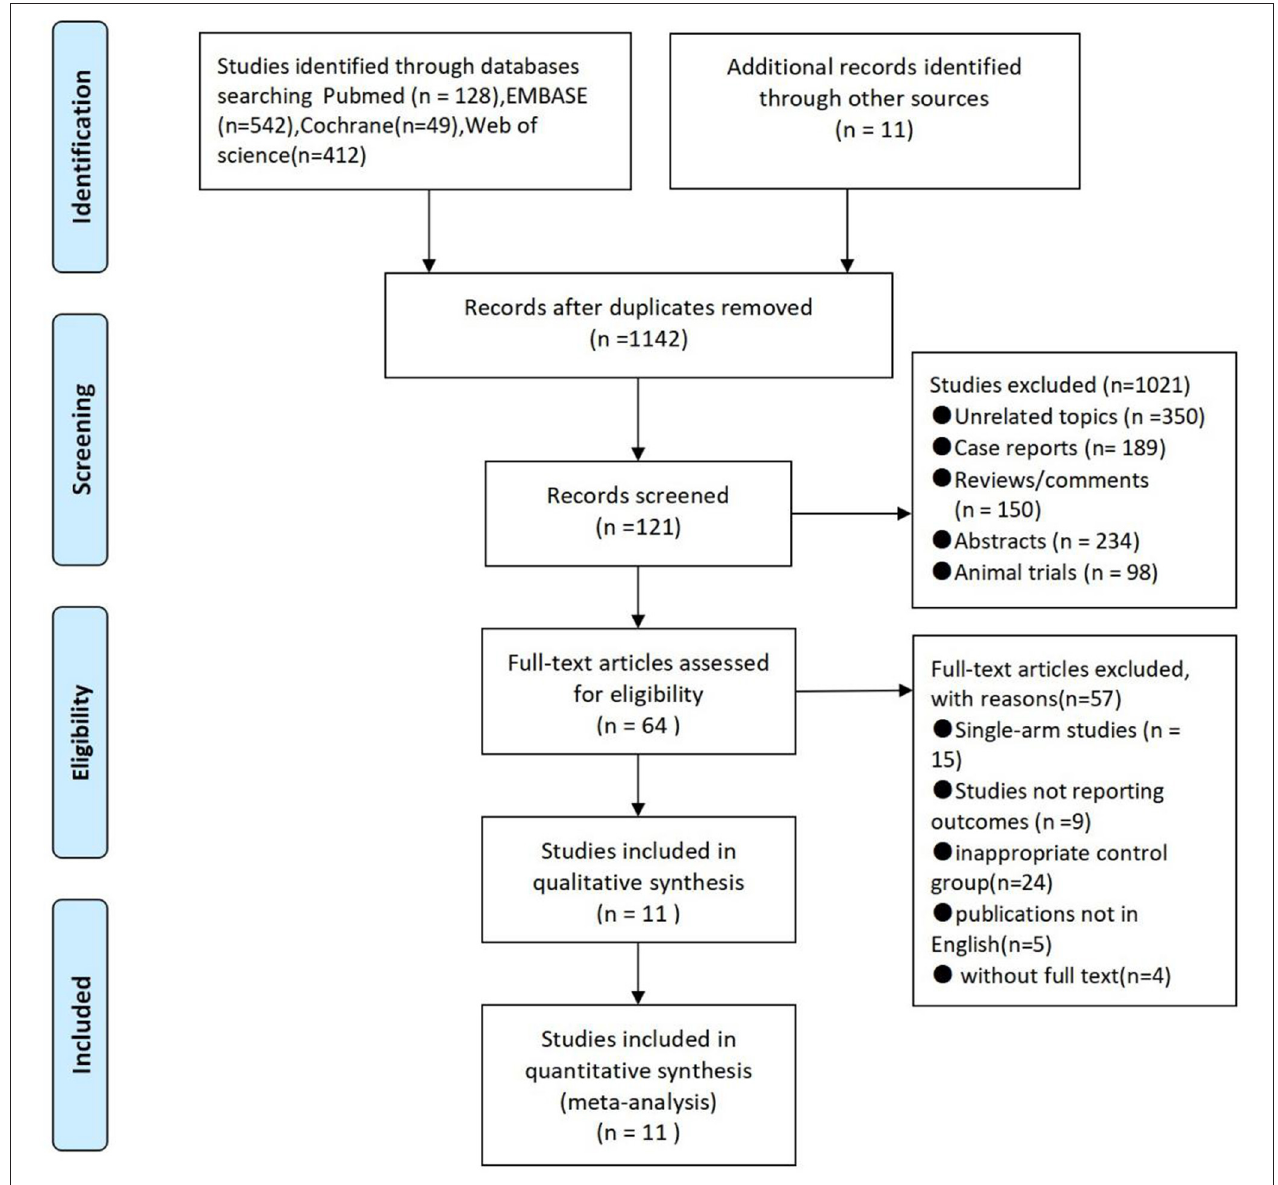
FIGURE 1 | Flow diagram of study